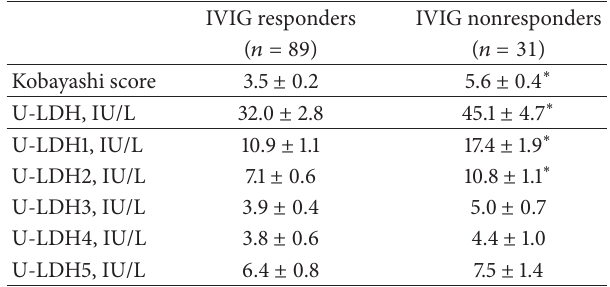
Table 3: A comparison of U-LDH and its isozyme patterns between IVIG responders and nonresponders groups with